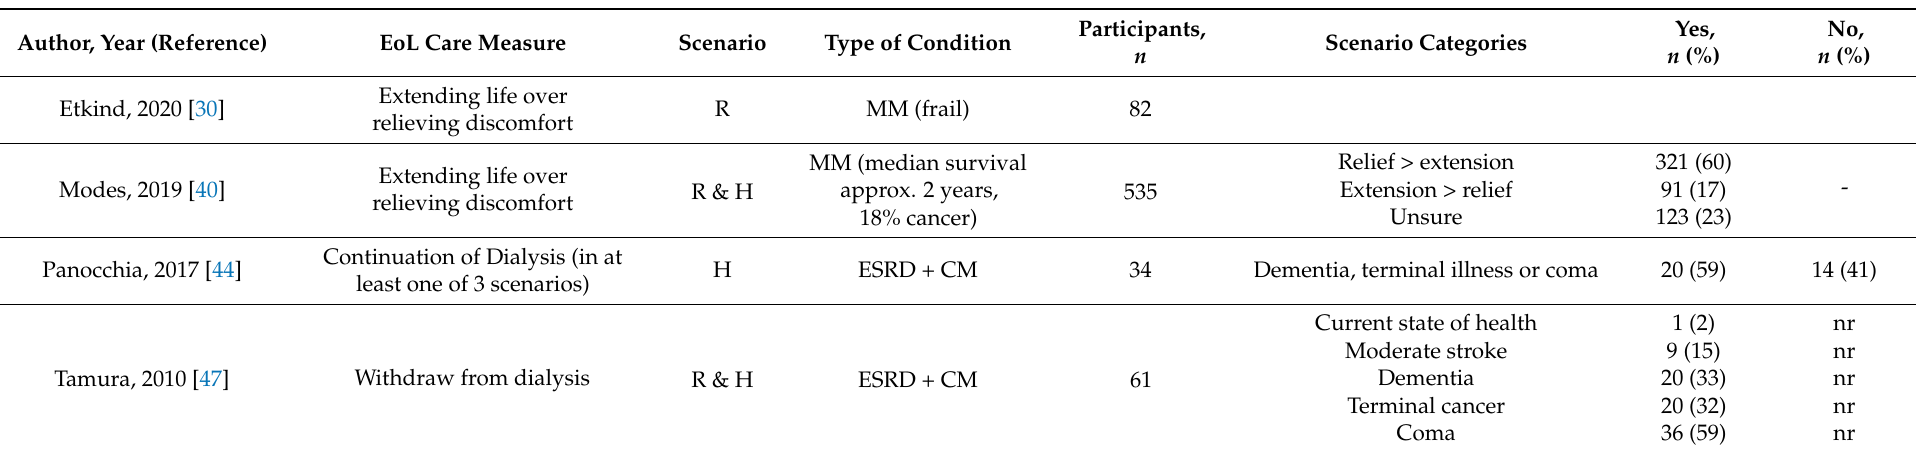
Table 4. Other EoL care